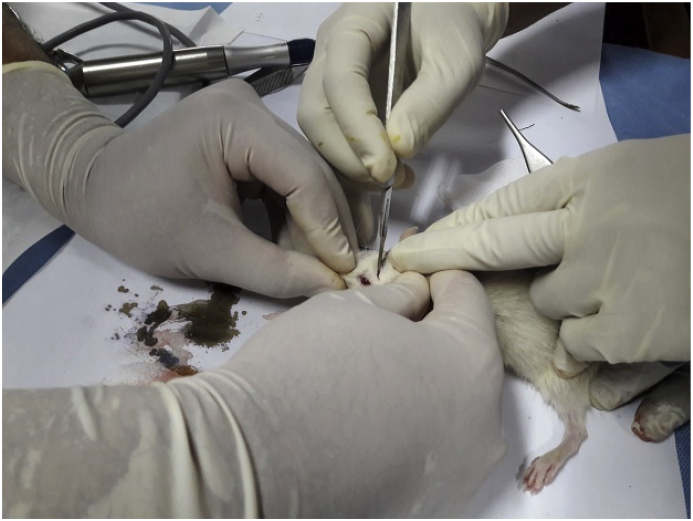
Surgical process.